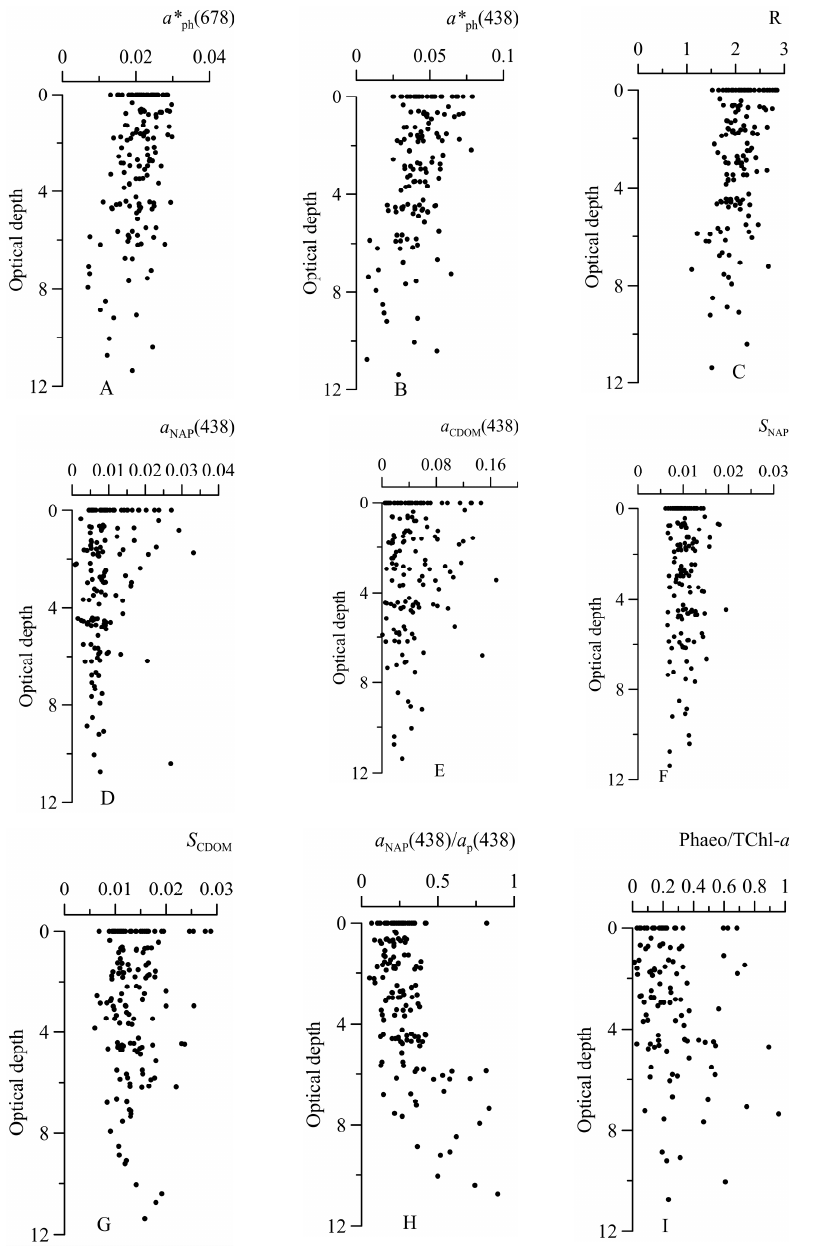
Figure 4. Vertical distribution of the chlorophyll a specific light absorption coefficient of phyto- plankton at 678 nm ( 𝑎 (cid:3043)(cid:3035)∗ (678) ) ( A ) and at 438 nm ( 𝑎 (cid:3043)(cid:3035)∗ (438) ) ( B ), the ratio between 𝑎 (cid:3043)(cid:3035)∗ (438)/𝑎 (cid:3043)(cid:3035)∗ (678) (R) ( C ), light absorption by non-algal particles at 438 nm ( 𝑎 (cid:3015)(cid:3002)(cid:3017) (438) ) ( D ) and colored dissolved organic matter at 438 nm ( 𝑎 (cid:3004)(cid:3005)(cid:3016)(cid:3014) (438) ) ( E ), the spectral slope of NAP (S NAP ) ( F ) and of CDOM ( S CDOM ) ( G ), the ratio between 𝑎 (cid:3015)(cid:3002)(cid:3017) (438) and particulate absorption ( 𝑎 (cid:3015)(cid:3002)(cid:3017) (438)/ 𝑎 (cid:3043) (438) ) ( H ) and ration between phaeopigments and its sum with chlorophyll a concentration ( I ) with optical depth. Mostly 𝑎 (cid:3043)(cid:3035)∗ (438) and 𝑎 (cid:3043)(cid:3035)∗ (678) values did not differ in the surface layer and within the euphotic zone (Figure 4). For the surface and the layer at the end of the photosynthesis zone (10–1% PAR), the dependences of 𝑎 (cid:3043)(cid:3035) (𝜆) on TChl-a at 438 and 678 nm were ob- tained. Based on Fisher’s and Student’s criteria [54], it was found (for 95% reliability) that they are not statistically distinguishable. Therefore, a relationship between 𝑎 (cid:3043)(cid:3035) (438) (or 𝑎 (cid:3043)(cid:3035) (678) ) and TChl- a was determined on the dataset obtained in the water layer above 1 % PAR in the form of a power law (see Equation (7)) (Figure 5). The obtained high values